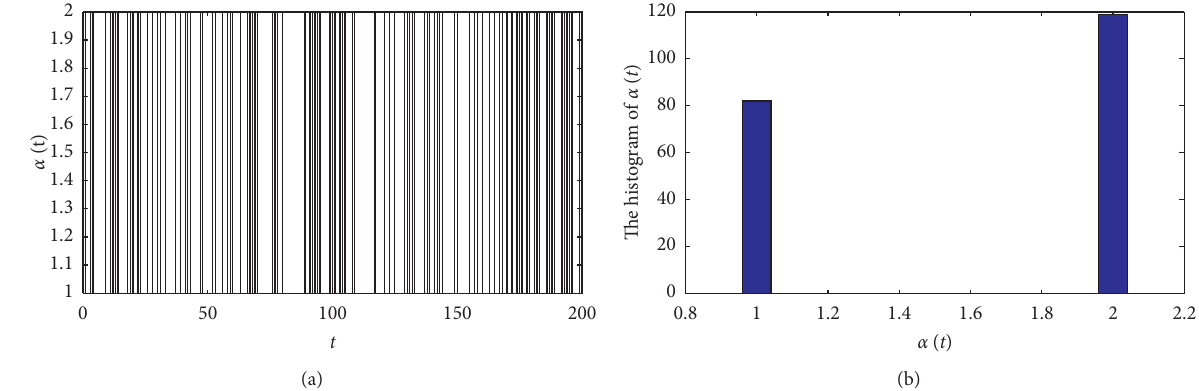
Figure 3: Distribution of the switching α ( t ) . (a) The time series of α ( t ) . (b) The histogram of α ( t ) .